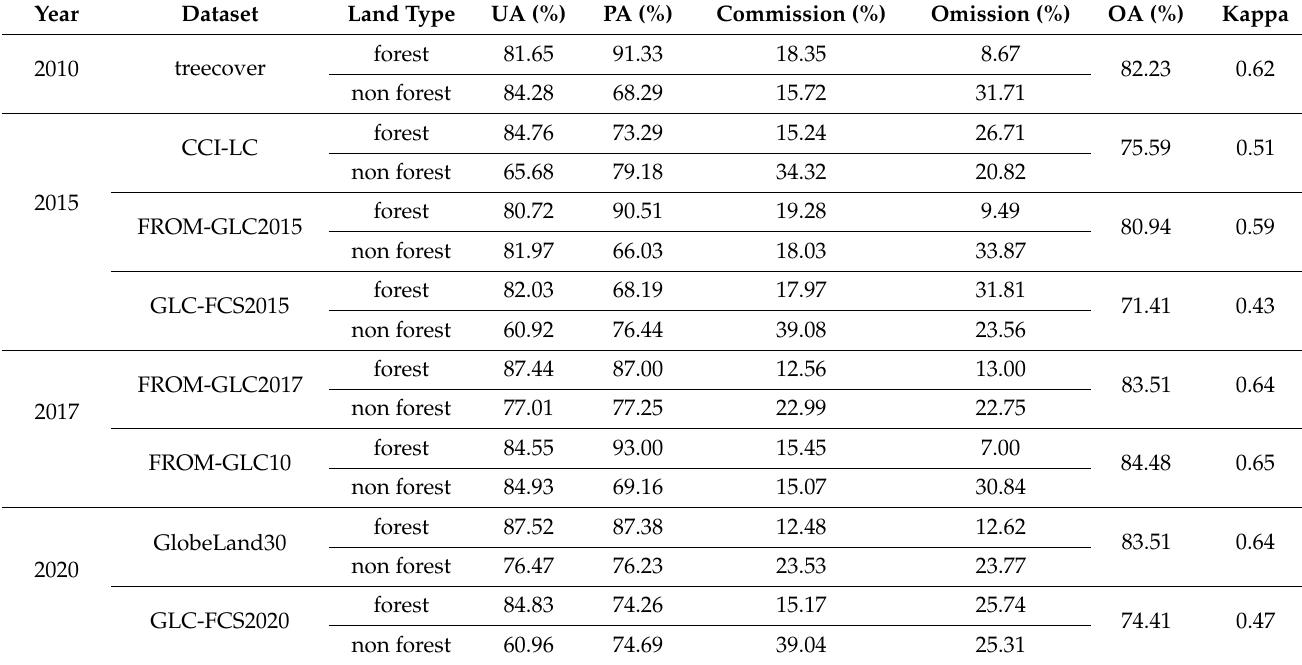
Table 3. Confusion matrix for eight forest land